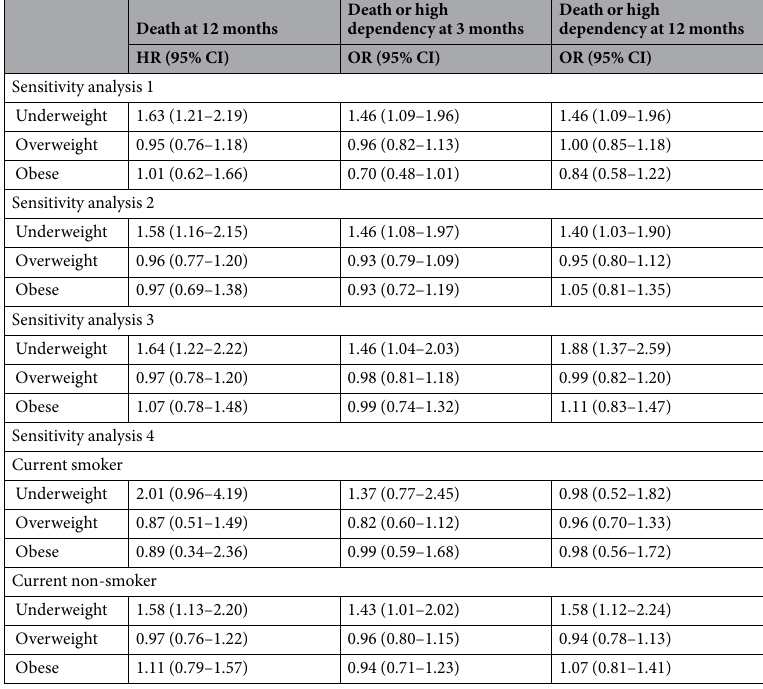
Table 5. Sensitivity analysis: Body mass index and death at 12 months, death or high dependency at 3 and 12 months. CI, confidence interval; HR, hazard ratio; OR, odds ratio. The normal-weight group was the reference group. Sensitivity analysis 1 used the World Health Organization BMI criteria, which included 282 underweight patients (BMI < 18.5 kg/m 2 ), 2889 normal-weight patients (BMI 18.5 to < 25 kg/m 2 ), 1408 overweight patients (BMI 25 to < 30 kg/m 2 ) and 203 obese patients (BMI ≥ 30 kg/m 2 ). Sensitivity analysis 2 excluded 234 patients who had received thrombolysis treatment, leaving 274 underweight patients, 2210 normal-weight patients, 1579 overweight patients and 485 obese patients in the analysis. Sensitivity analysis 3 redefined high dependency as a modified Rankin scale score of 4–5. Sensitivity analysis 4 was a stratified analysis according to smoking status (current smoker and current non-smoker). In 1375 patients of current smoker, there were 76 underweight patients, 670 normal-weight patients, 509 overweight patients and 120 obese patients. In 3407 patients of current non-smoker, there were 206 underweight patients, 1636 normal-weight patients, 1168 overweight patients and 397 obese